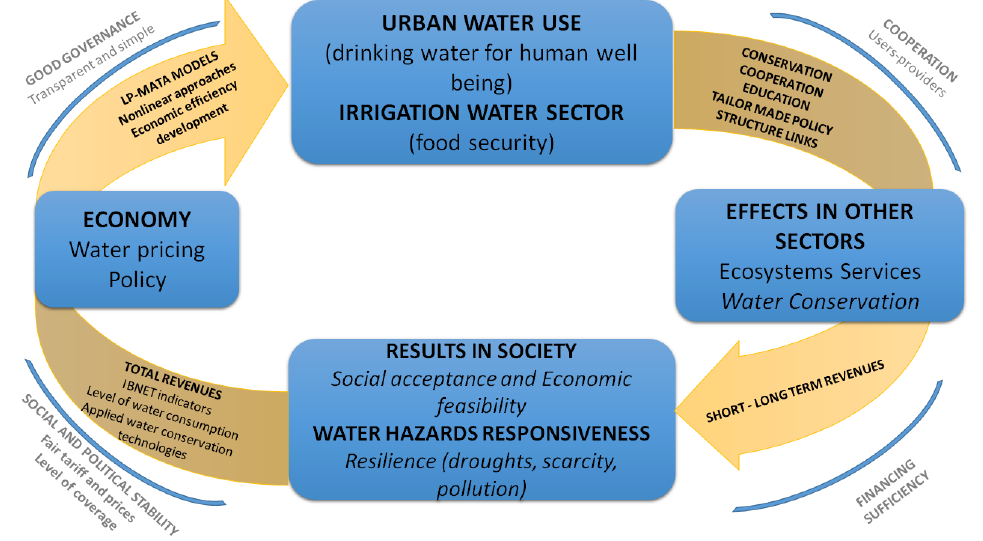
Figure 6. Suggested model for water pricing embedding water security guiding framework.